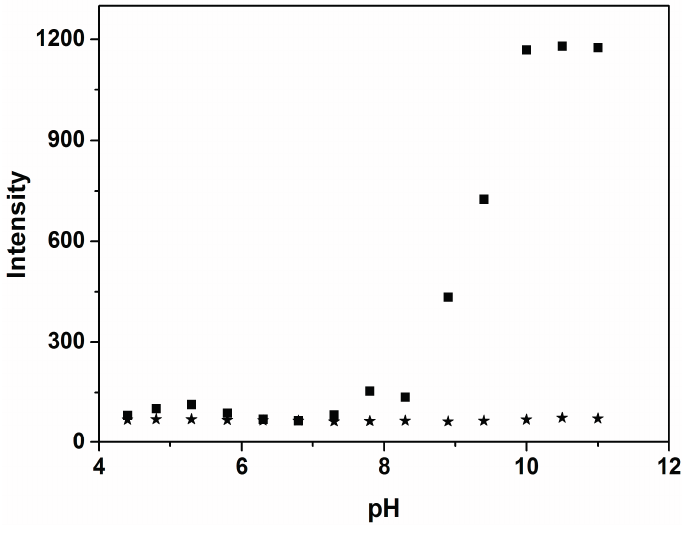
Figure 1. pH-dependence of P (10 µM) (  ) and P (10 µM) plus Mg 2+ (100 µM) ( ■ ) in HEPES buffers as a function of different pH values in ethanol-water solution (9:1, v:v, 20 mM HEPES). The pH was modulated by adding 1.0 M HCl or 1.0 M NaOH in HEPES